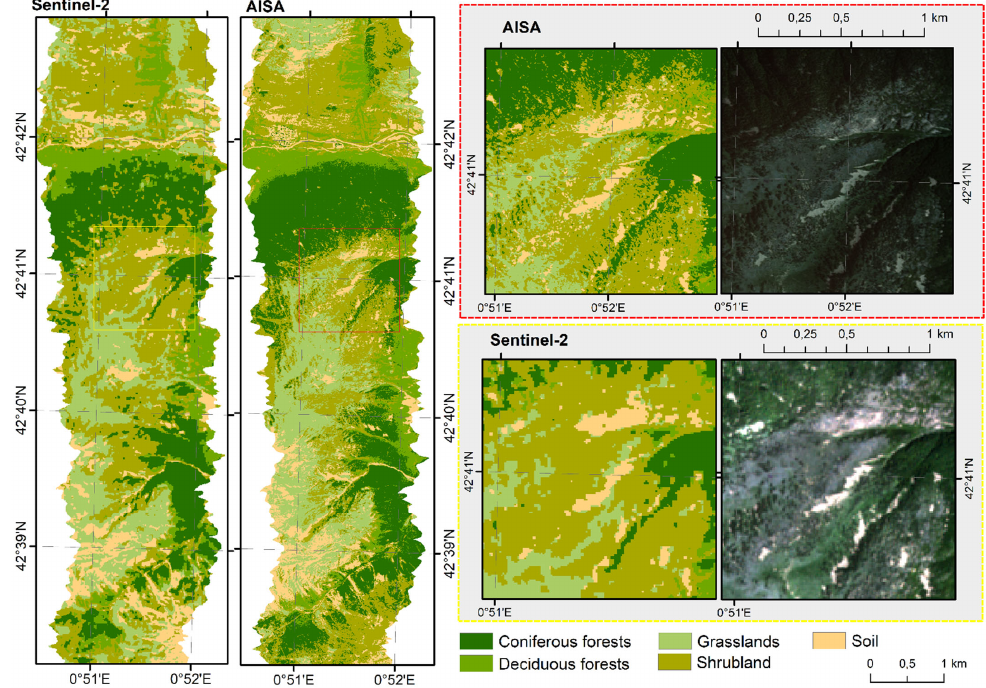
Figure 7. Classification RF results for the Sentinel-2 (Images+CHM data set) and AISA data (MNF+CHM+INDICES data set) for the A area.